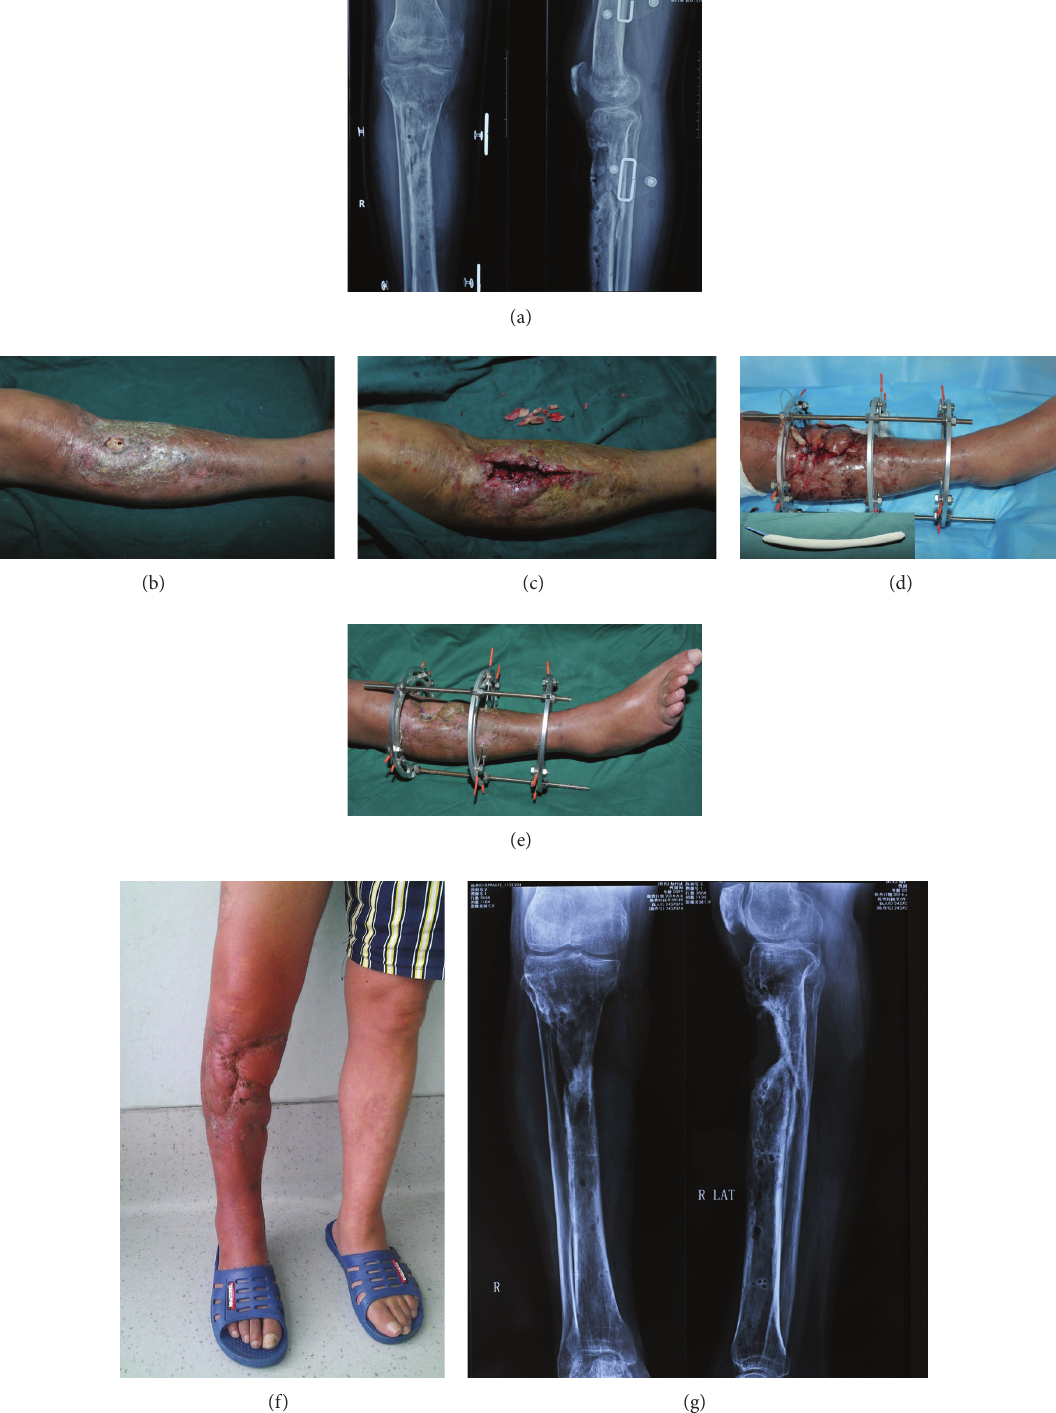
Figure 2: A 35-year-old male with a proximal diaphyseal fracture had received a plate fixation and later was removed due to IRI (a). A sinus existed in the proximal tibia and the bone was exposed (b). During the debridement, all the dead bones were removed (c). The wound was closed with the medial gastrocnemius flap and vancomycin cement rod in site (d). Two months later, the wound healed (e). At two-year follow-up, the wound and the bone healed well. The patient could walk normally ((f),